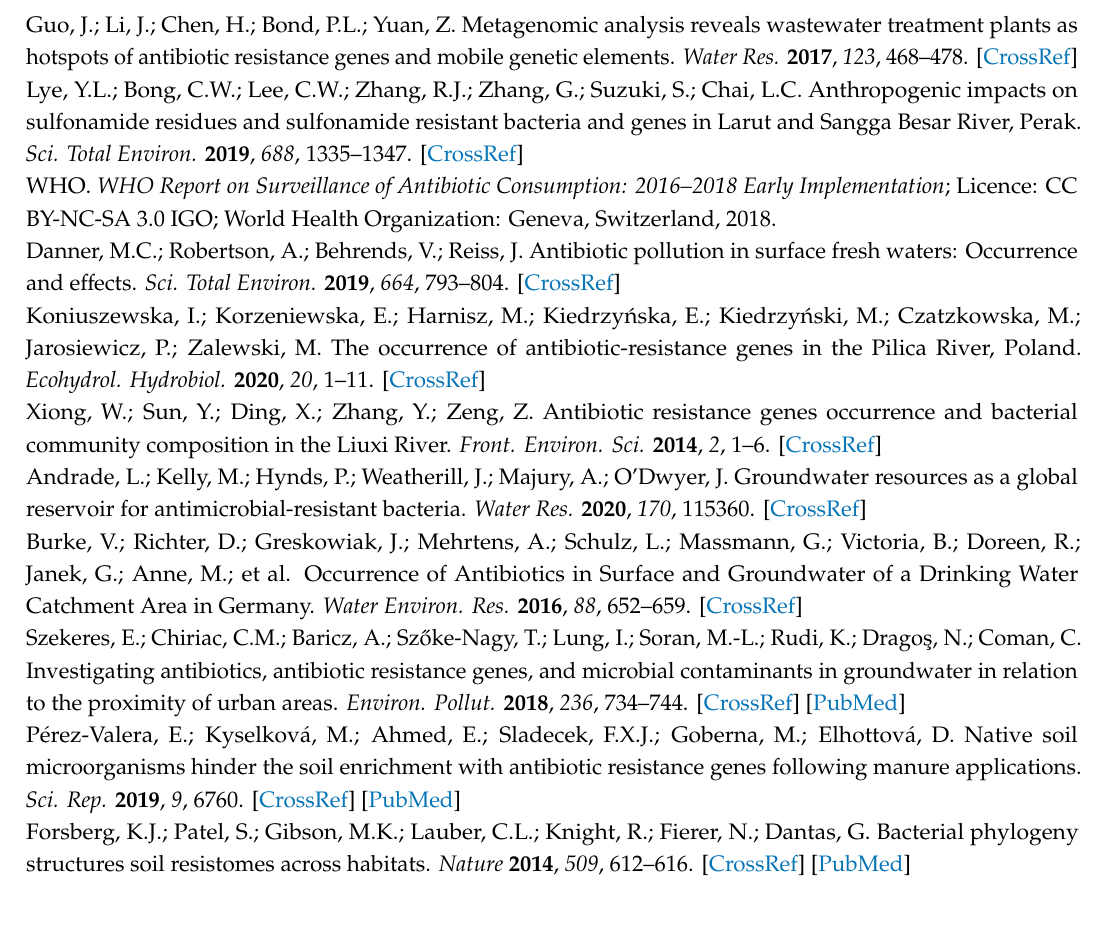
Supplementary Materials: The following are available online at http: // www.mdpi.com / 2076-3417 / 10 / 17 / 5816 / s1, Figure S1: Similarity of samples, based on the occurrence of antibiotic-resistance genes